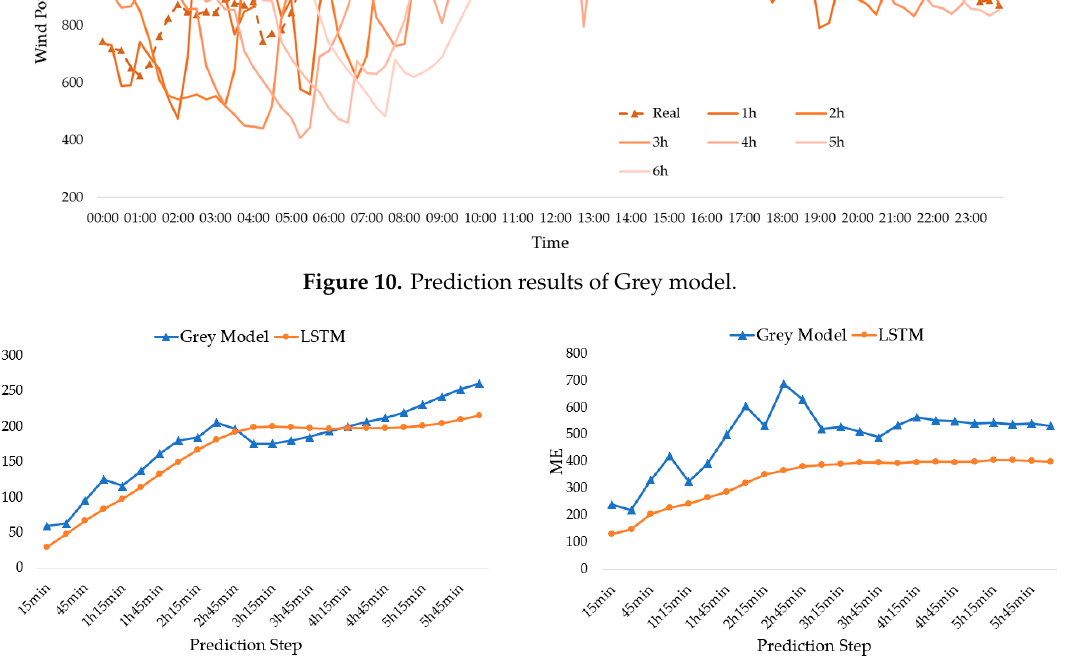
Figure 11. Comparison of prediction errors of Grey Model and LSTM: ( a ) root mean square error; ( b ) maximum error.